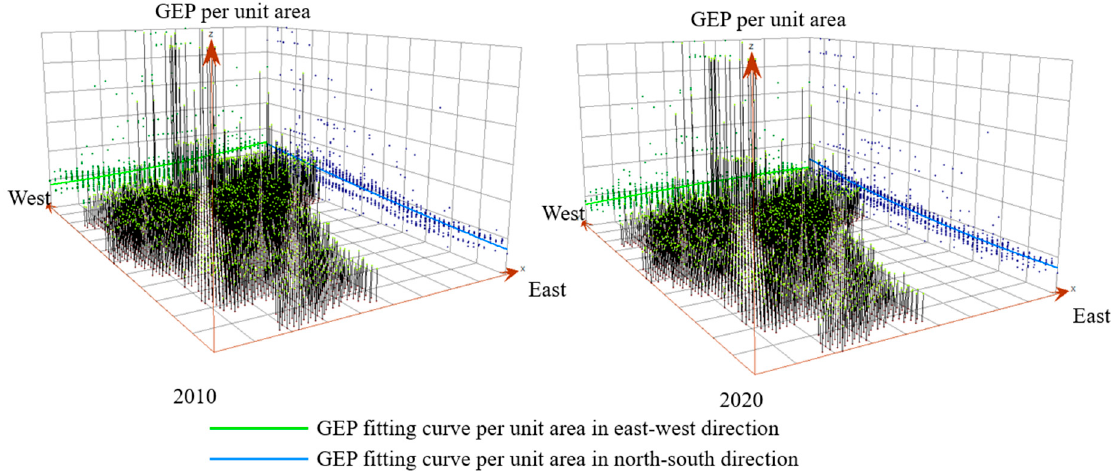
Figure 5. Evolution of GEP trend surface per unit area in Jiangxi Province in 2010 and 2020.